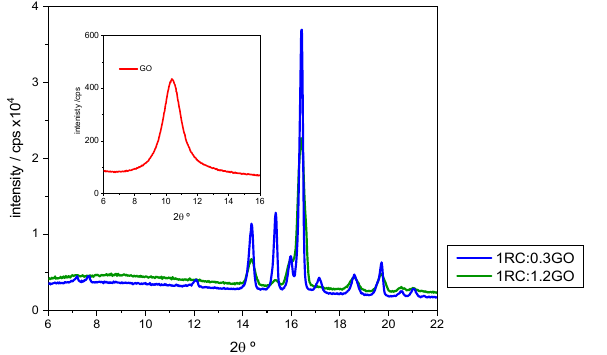
Figure 3. Detail of the X-ray patterns corresponding to 1RC:0.3GO and 1RC:1.2GO ratios. The X-ray pattern of GO is given in the insert.